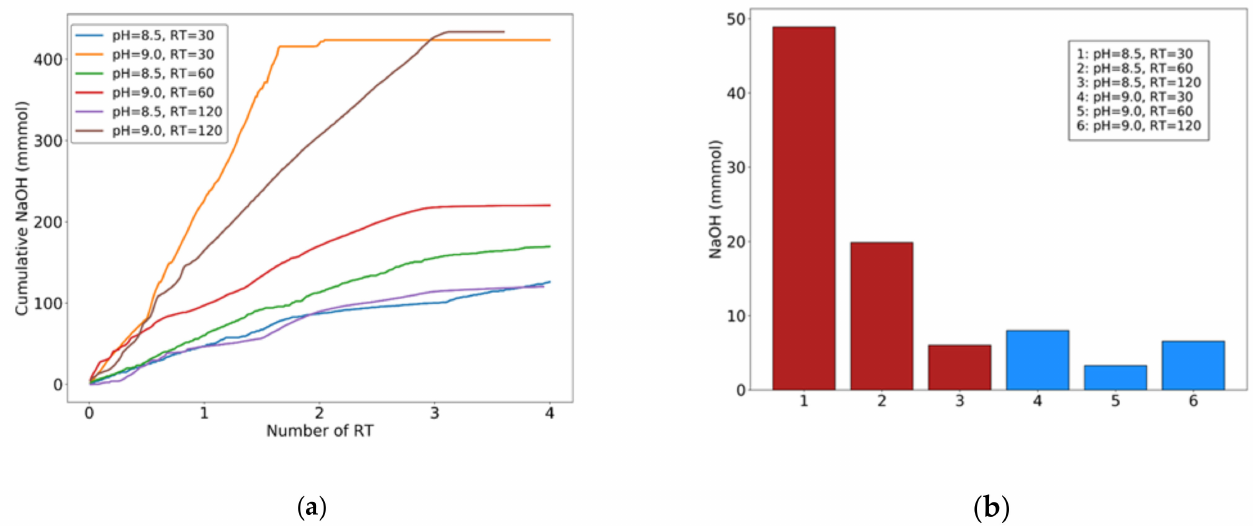
Figure 4. ( a ) Cumulative NaOH added for pH control with respect to HRT. ( b ): NaOH added to the reactor after 3 retention times. RT: retention